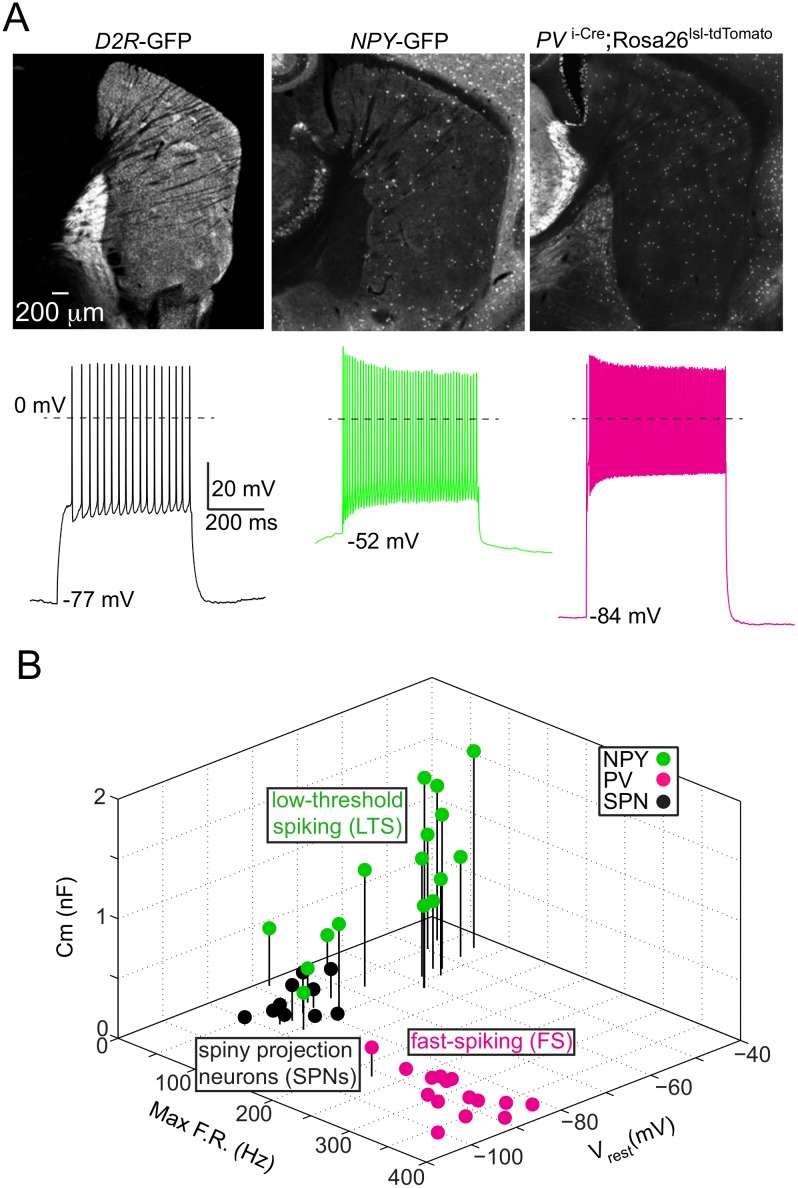
Molecular markers distinguish low-threshold spiking (LTS) and fast-spiking (FS) striatal interneurons from spiny projection neurons (SPNs).(A) Top, sagittal brain sections from transgenic mice used to distinguish striatal cell types through selective expression of fluorescent proteins. The dopamine 2 receptor BAC (D2R-EGFP) drives EGFP selectively iSPNs, while the Neuropeptide Y BAC (NPY-EGFP) drives EGFP selectively in putative NPY+ LTS interneurons and a smaller number of NPY+ neurogliaform interneurons[51]. The PV
i-Cre;Rosa26lsl-tdTomato mouse expresses tdTomato in PV+ putative FS interneurons. Bottom, example membrane potential recordings for each fluorescently labeled cell type in response to current injections (500 ms, SPN: 200 pA; LTS: 400 pA; FS: 1500 pA). (B) Three-dimensional scatter plot of membrane capacitance (Cm), maximum firing rate (Max FR) and resting membrane potential (Vrest) for striatal cell types color-coded by expressed molecular marker.